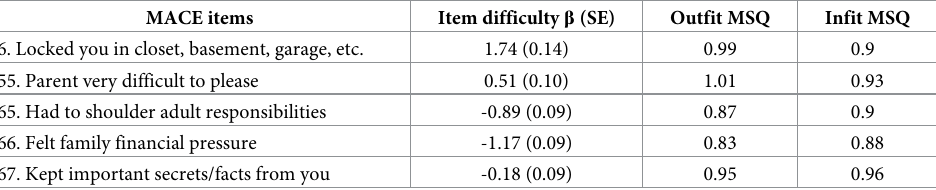
Table 3. Rasch analysis of parental non-verbal emotional